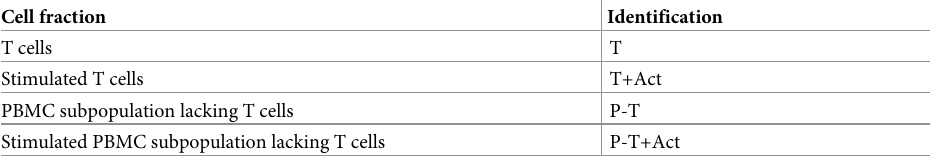
Table 2. Participants’ PBMCs subpopulation IDs, used for the TEM study. Cell